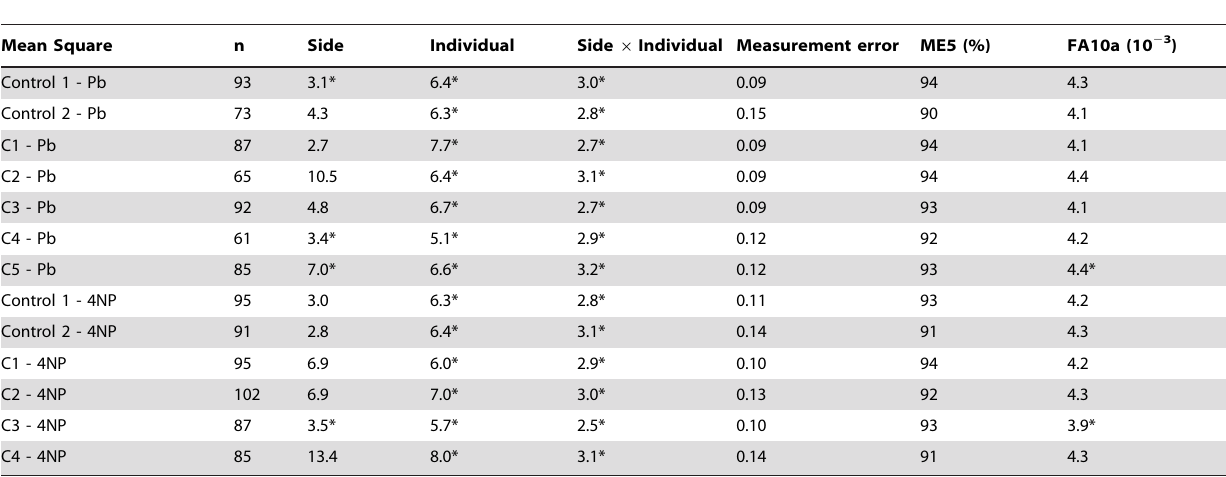
Table 4. Mean square values (10 2 5 ) of the two ways ANOVA (side x individual) for mentum shape, measurement error descriptor (ME5) and FA